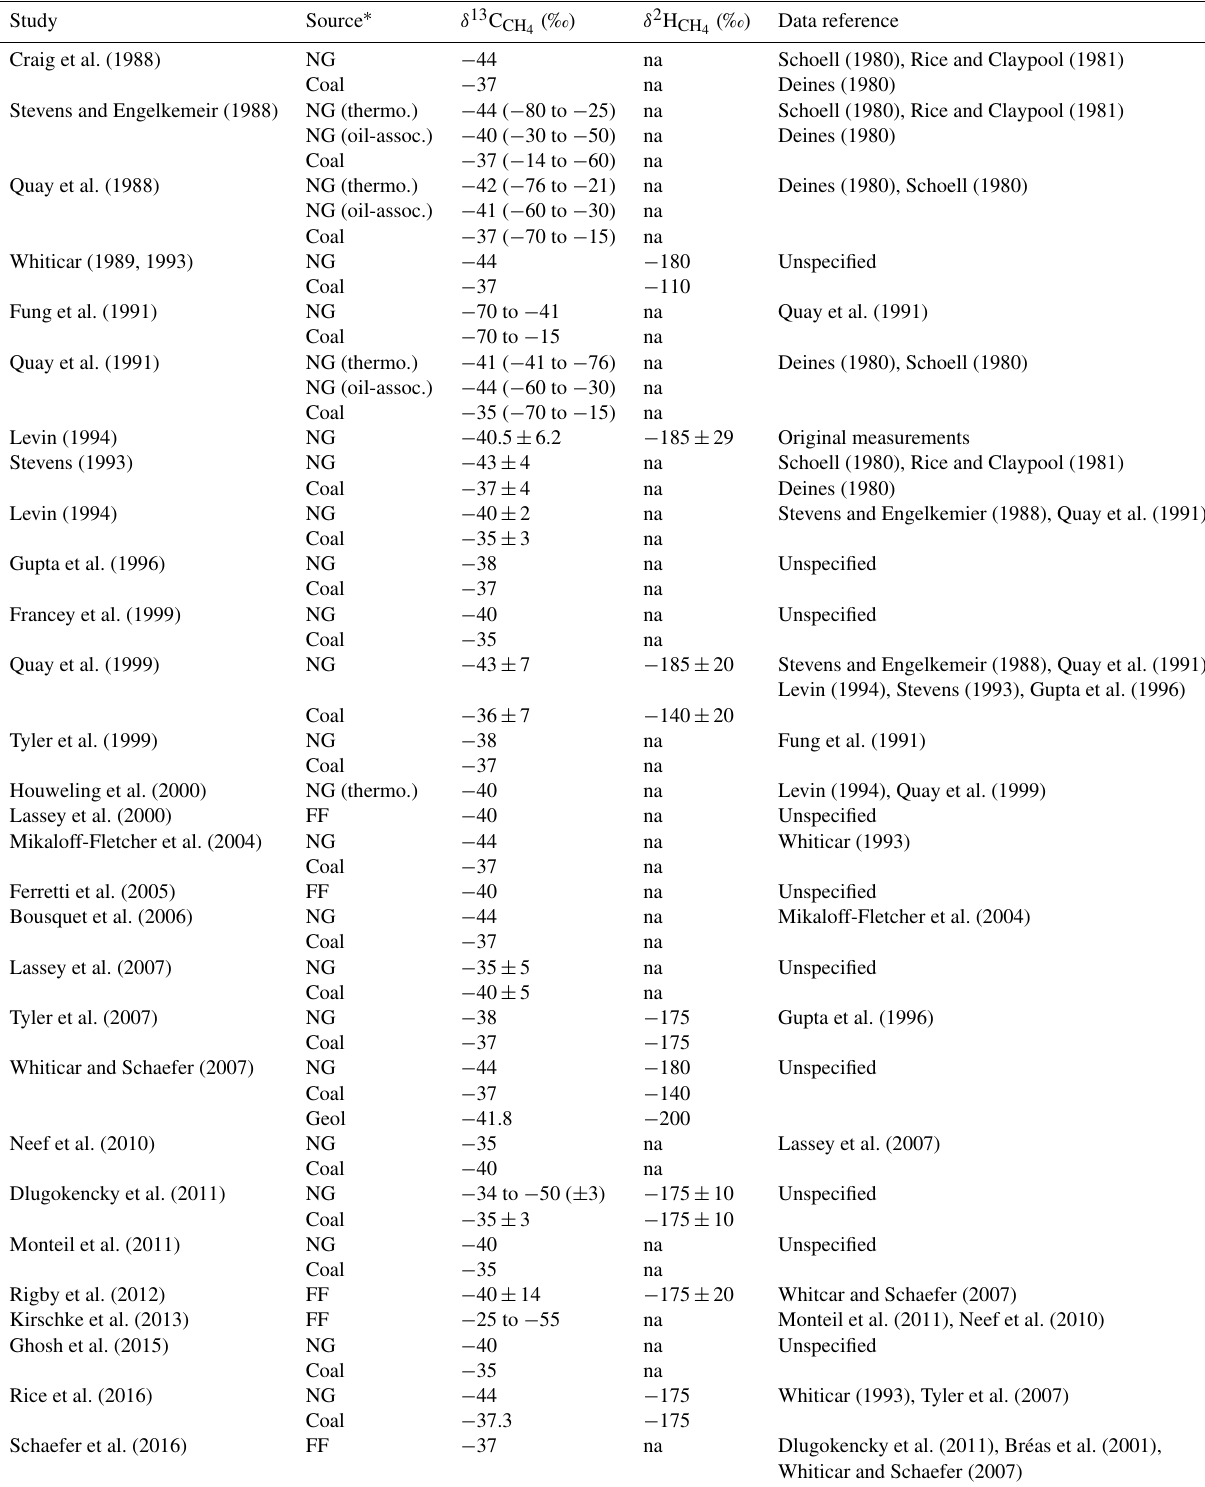
used and the source of those and δ 2 H CH 4 4